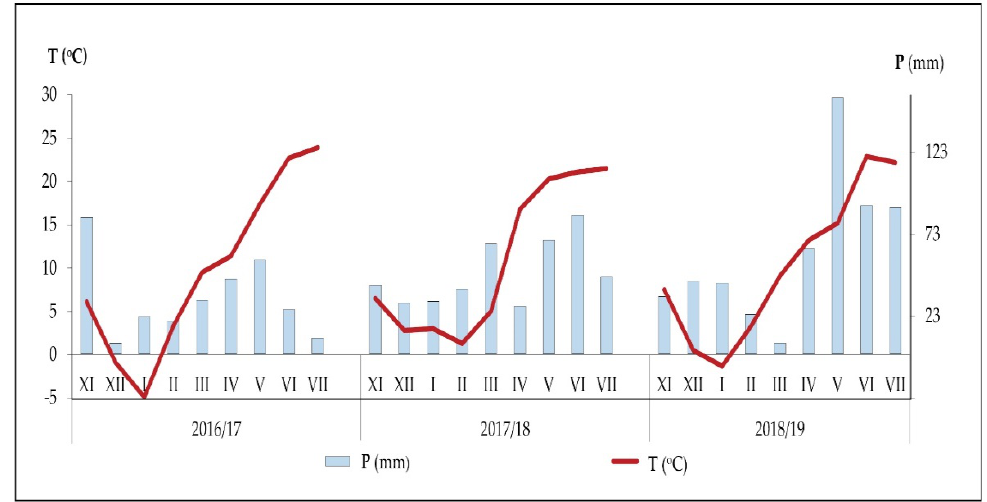
Figure 1. Precipitation (mm) and average air temperature ( ◦ C) during the microtrials, Pancevo, Republic of Serbia, 2016–2019, where T: presents temperature ( ◦ C); P: precipitation (mm).